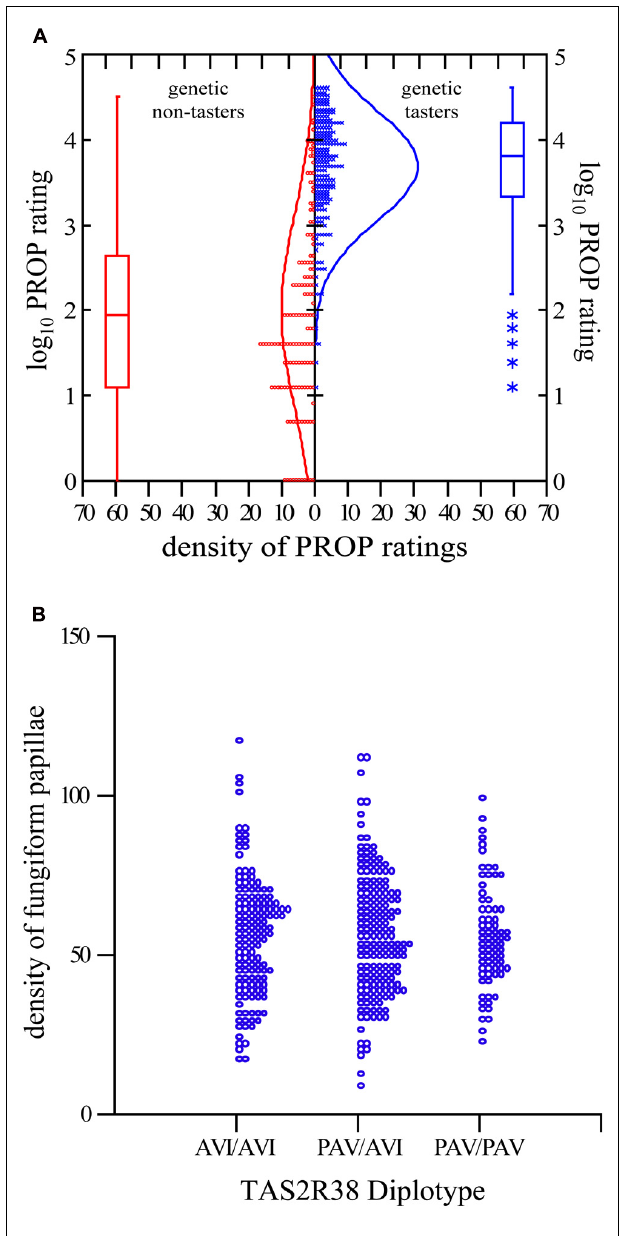
FIGURE 2 | TAS2R38 diplotype correlates to PROP intensity rating, and not FP. (A) Two-sample t -test comparing the logarithm base 10 of PROP for the genetic non-taster (AVI/AVI) diplotype and genetic taster diplotypes (PAV/AVI and PAV/PAV) p < 0.0001. Each o/x representing one person. *Indicates outliers. (B) Dot density comparing the FP density for the three major diplotypes. Analysis of variance to compare means reports p = 0.947. Each o represents one person.